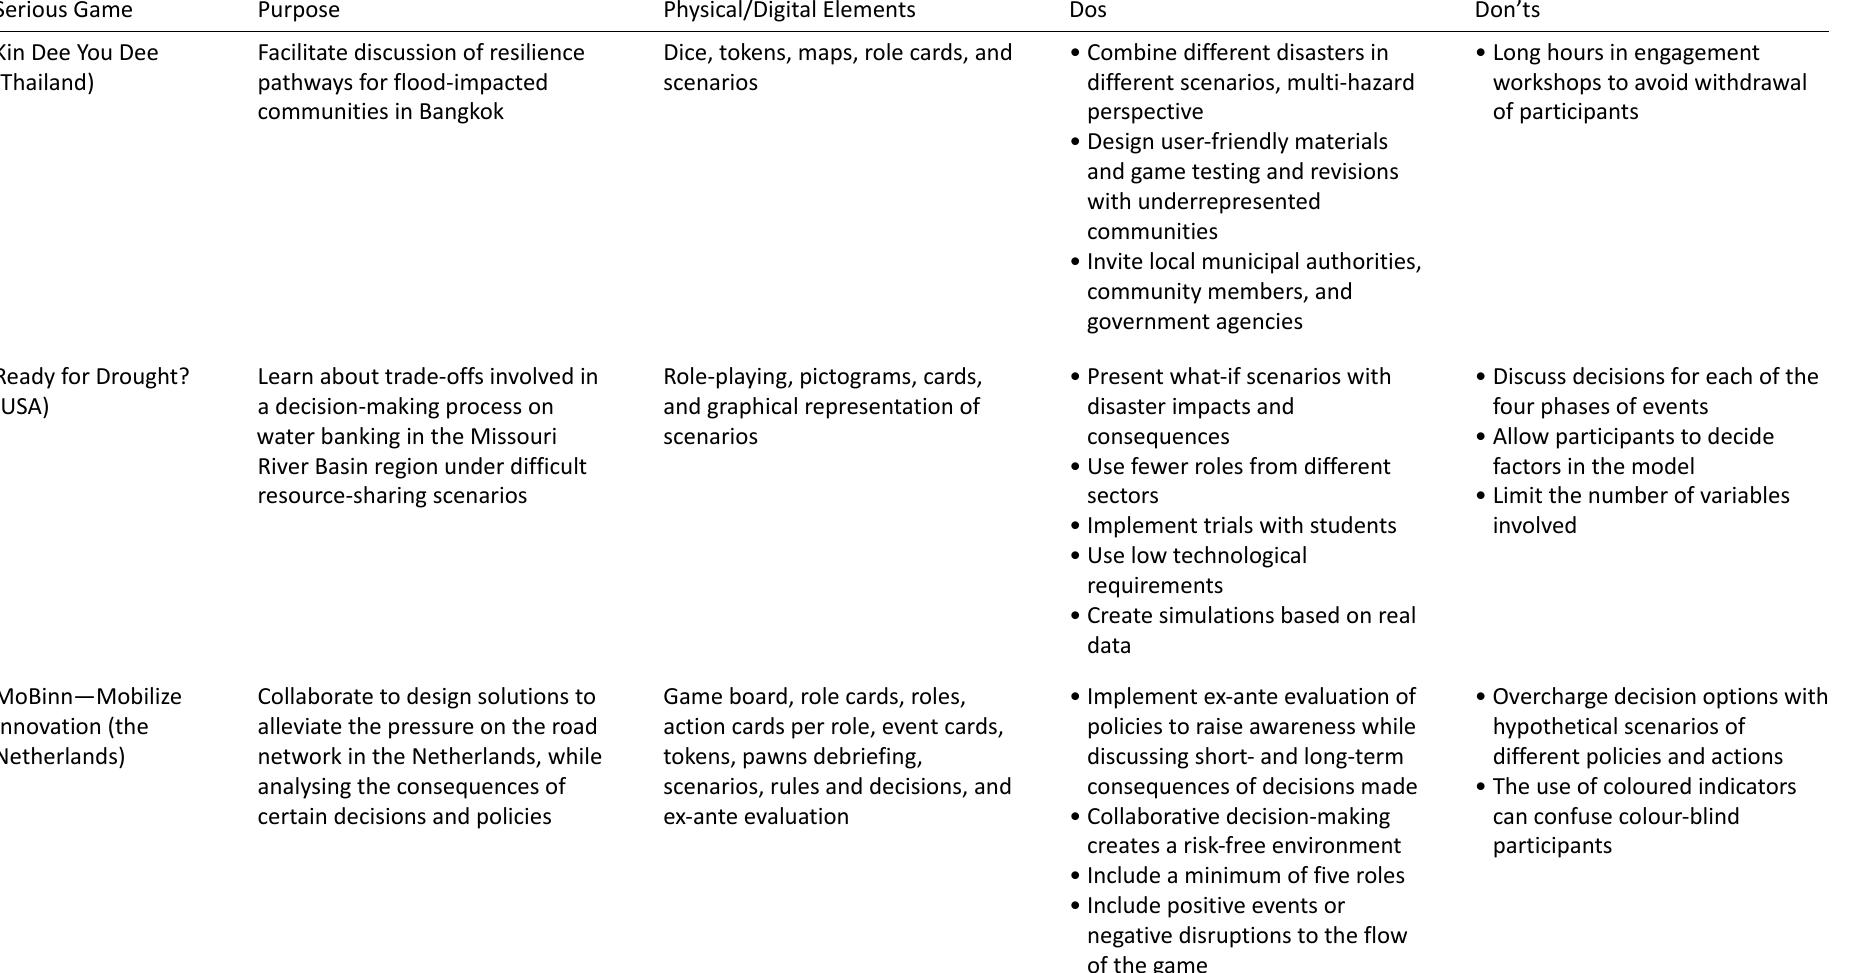
Table 2. Derived dos and don’ts analysis based on serious games as research instruments in